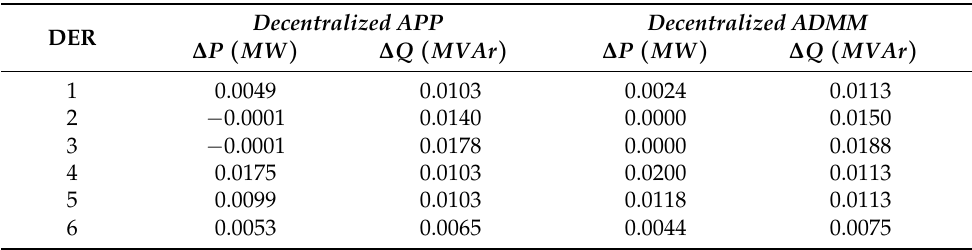
Table 4. Variations with respect to the initial operating condition of the active and reactive powers injected/absorbed by DERs for the Decentralized APP and the Decentralized ADMM .